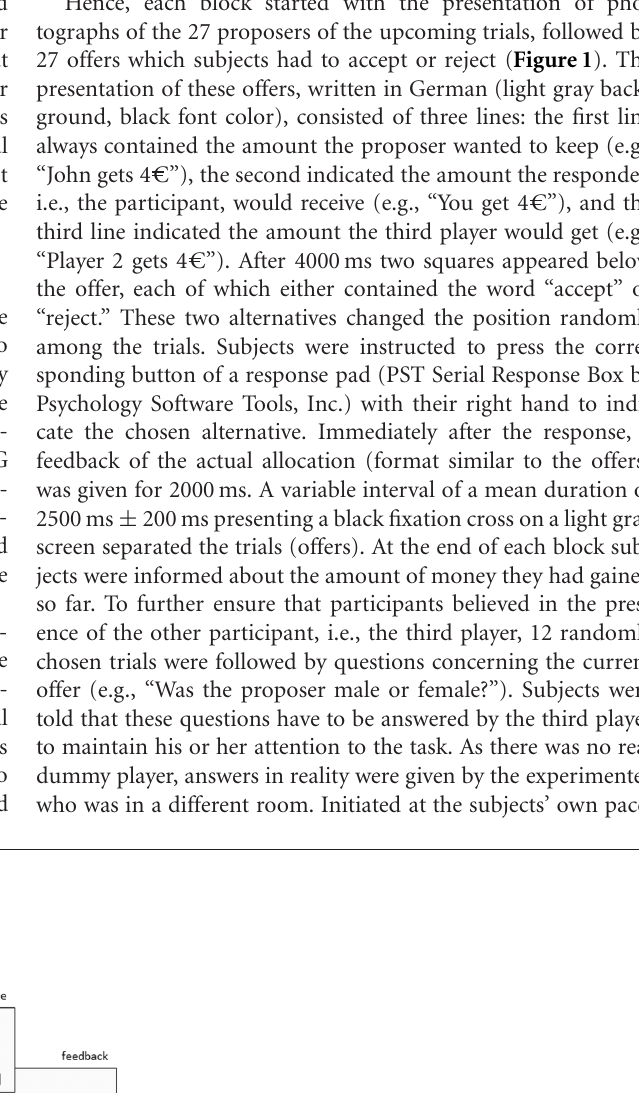
that participants can respond. Upon pressing the button, the feedback was presented. On 12 randomly chosen trials the feedback was followed by questions to be answered by the third